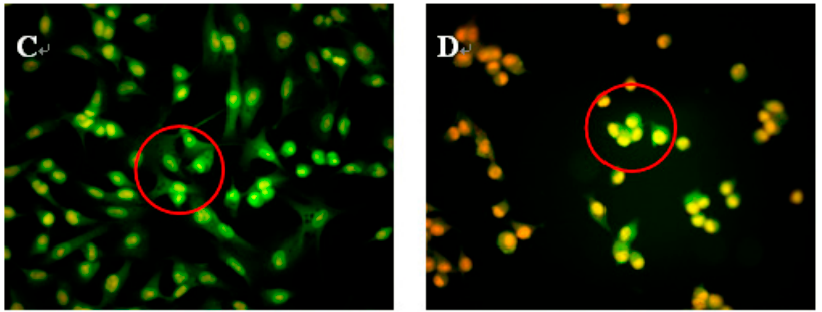
Figure 3. Morphological observation by AO/EB staining (200×). H1299 cells ( A ) were untreated, treated with 30 μ g/mL NAP ( B ); with 40 μ g/mL NAP ( C ); and with 50 μ g/mL NAP ( D ). The red circle in Figure 3B indicates viable cells; the red circle in Figure 3C indicates early apoptotic cells; the red circle in Figure 3D indicates the late apoptotic cells. Each experiment has been done in triplicate ( n = 3) and had similar morphological characteristics.